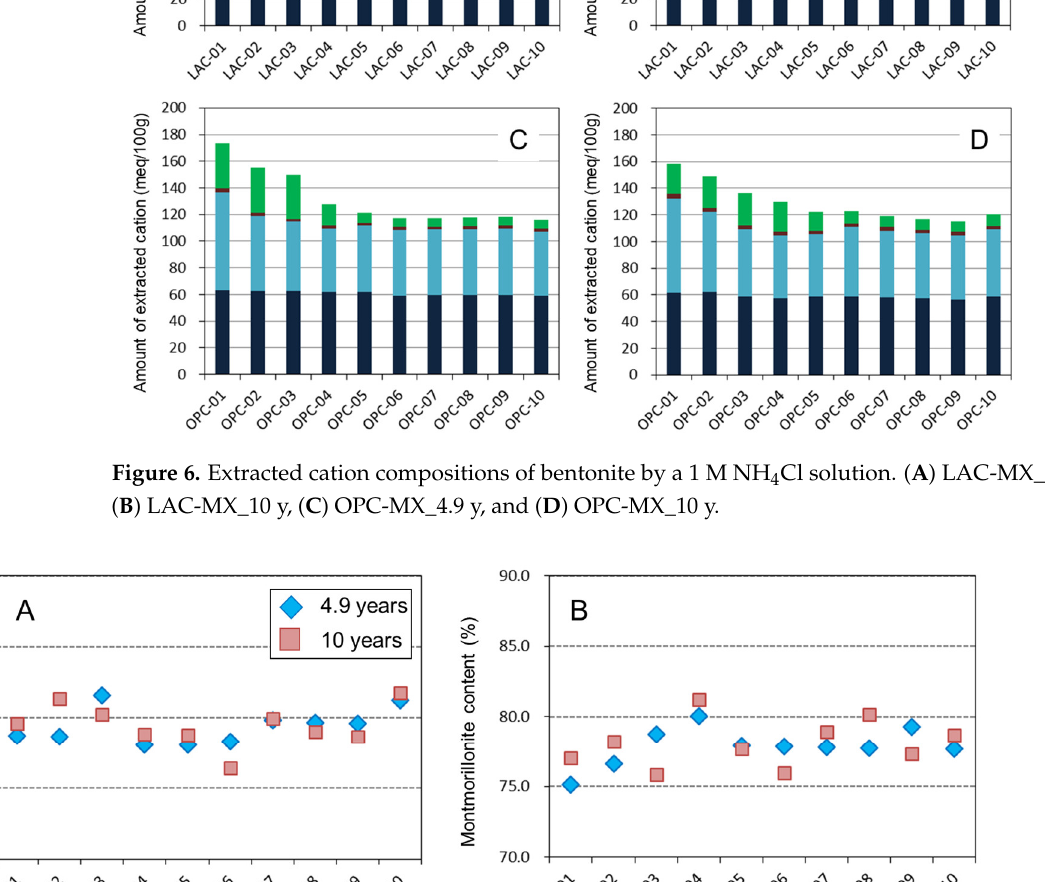
squares) years. squares)